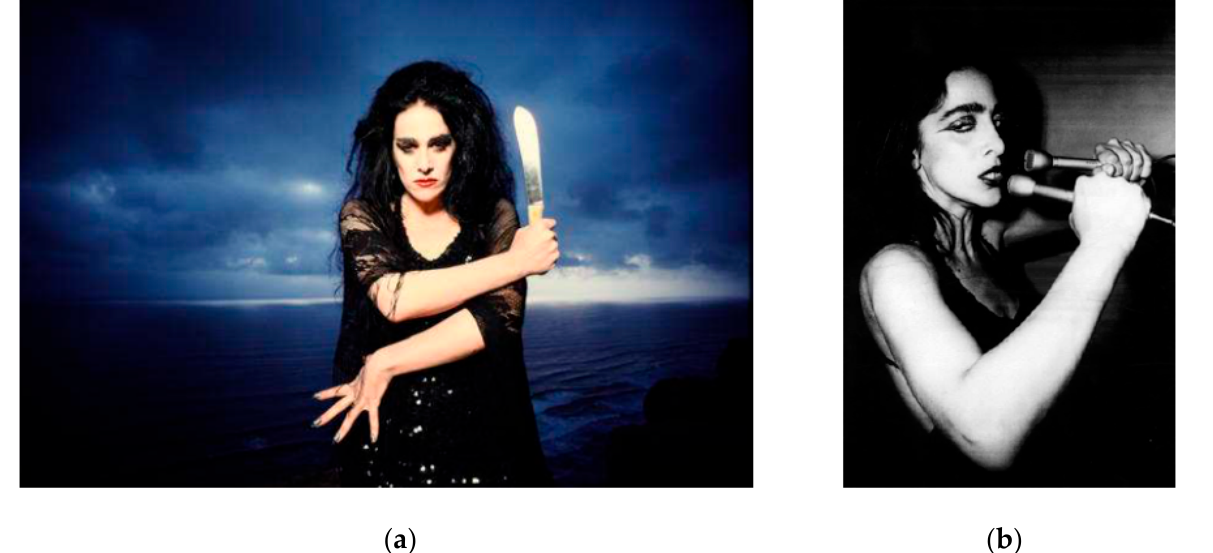
Figure 14. ( a ) Diamanda Galás, 24 February 1985, San Diego, California. Photo by Paul Harris. ( b ) Diamanda Galás, c. 1983.